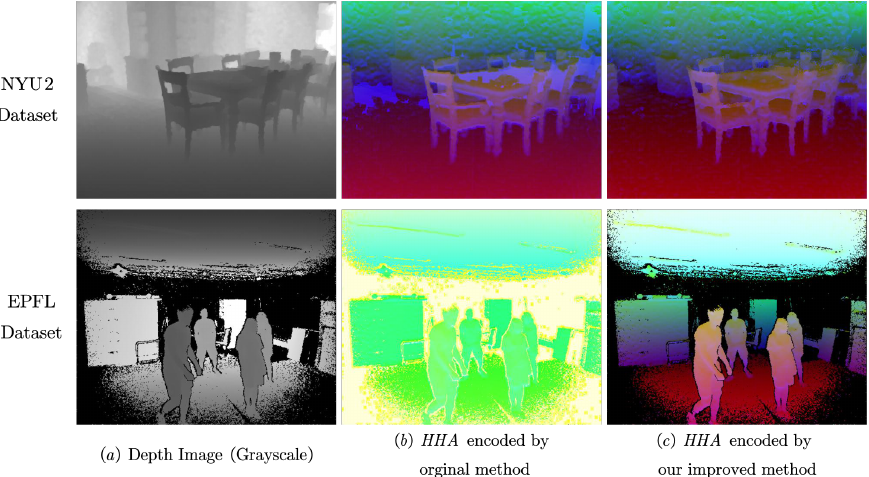
Figure 3. The encoded HHA images by the original and our improved methods on different